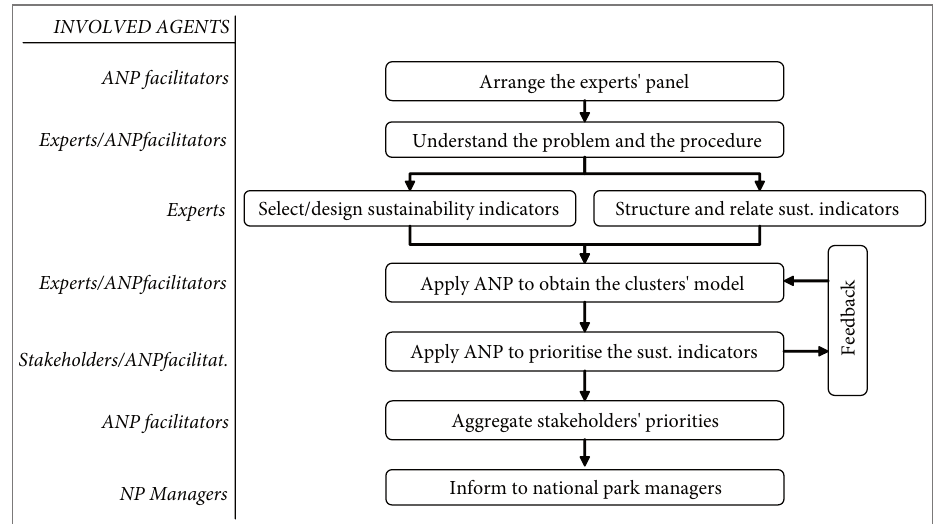
Fig. 1. General assessment